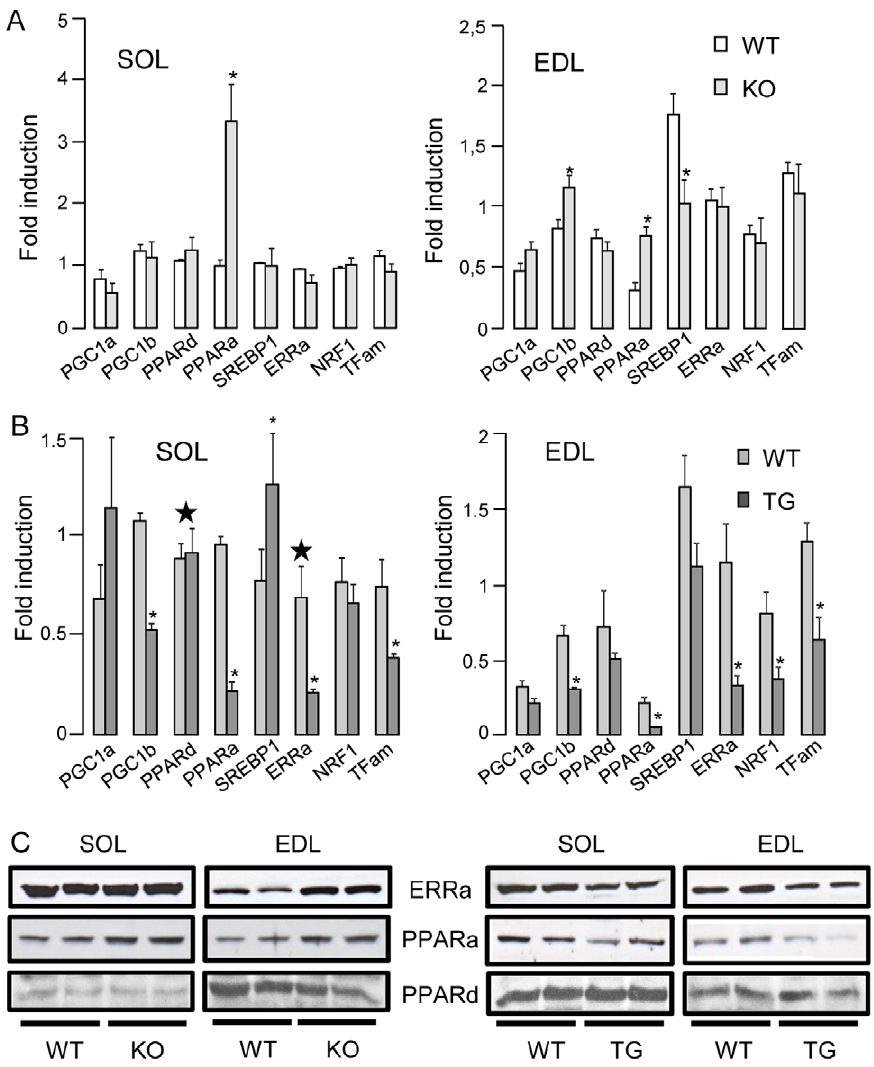
Figure 4. Modulation of RIP140 alters the expression of metabolic nuclear receptors and transcription factors. (A) Real-time RT-PCR analysis of metabolic nuclear receptors and transcription factors in soleus (SOL) and EDL of RIP140-null (KO) and WT mice. Data are comparable between histograms for the same gene and expressed as mean 6 SEM. *p , 0.05, WT vs KO. (B) Real-time RT-PCR analysis of metabolic nuclear receptors and transcription factors in soleus (SOL) and EDL of RIP140 transgenic (TG) and WT mice. Data are comparable between histograms for the same gene and expressed as mean 6 SEM. *p , 0.05, WT vs TG. ???Data were published already in [25]. (C) Analysis of ERR a , PPAR a , and PPAR b / d expression in RIP140-null (KO), transgenic (TG) and WT soleus (SOL) and EDL by western blot.